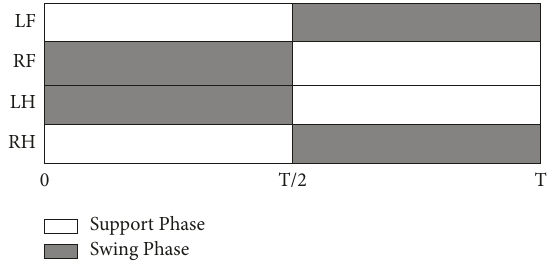
Figure 10: The timing diagram of the trot gait.